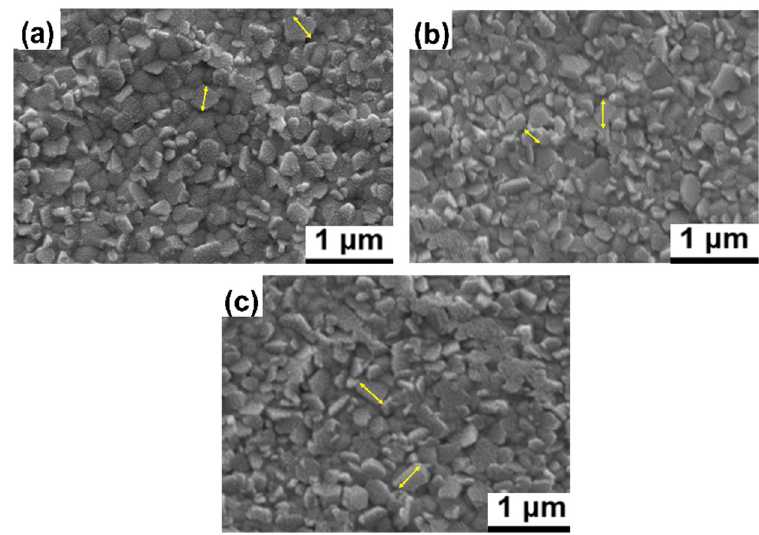
7 of 14 Figure 4. Absorbance spectra of perovskite on a PEDOT:PSS/Cu:NiO x /FTO/glass substrate and control device. 4.2. Microstructures of Layered Films of Perovskite Solar Cells The SEM images of the layered films of the perovskite solar cells are presented in